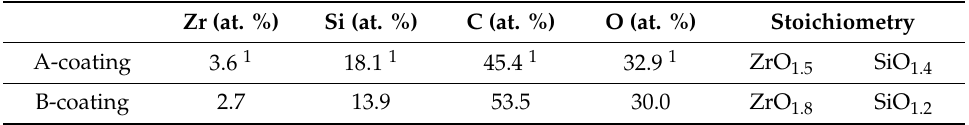
Table 4. Atomic percentage of Zr, Si, C and O in the materials derived from sols A and B after Ar etching and calculated stoichiometry.